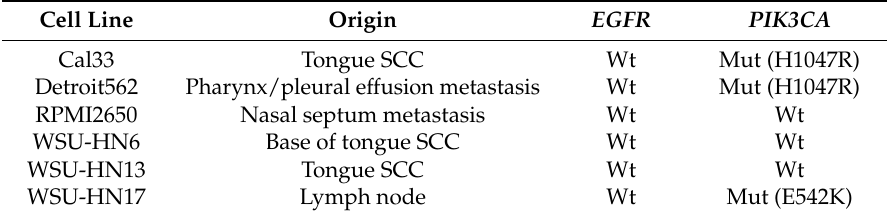
Table 1. HNSCC cell lines.